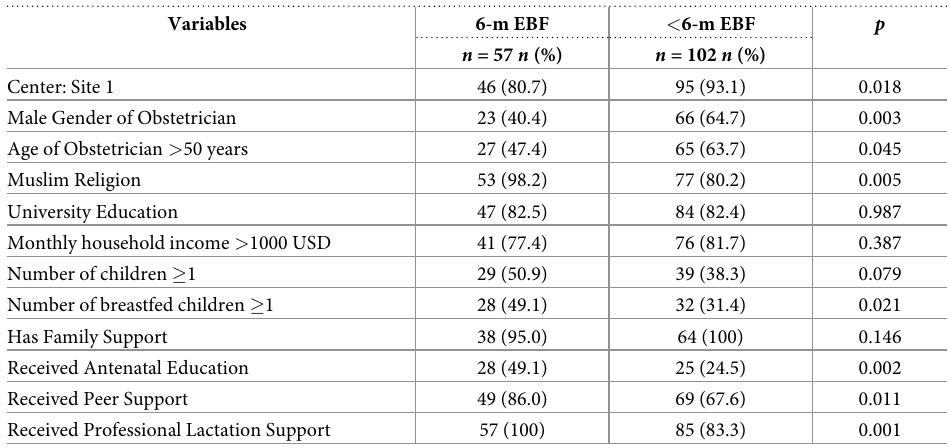
Table 2. Frequency distribution of participants characteristics ( N =